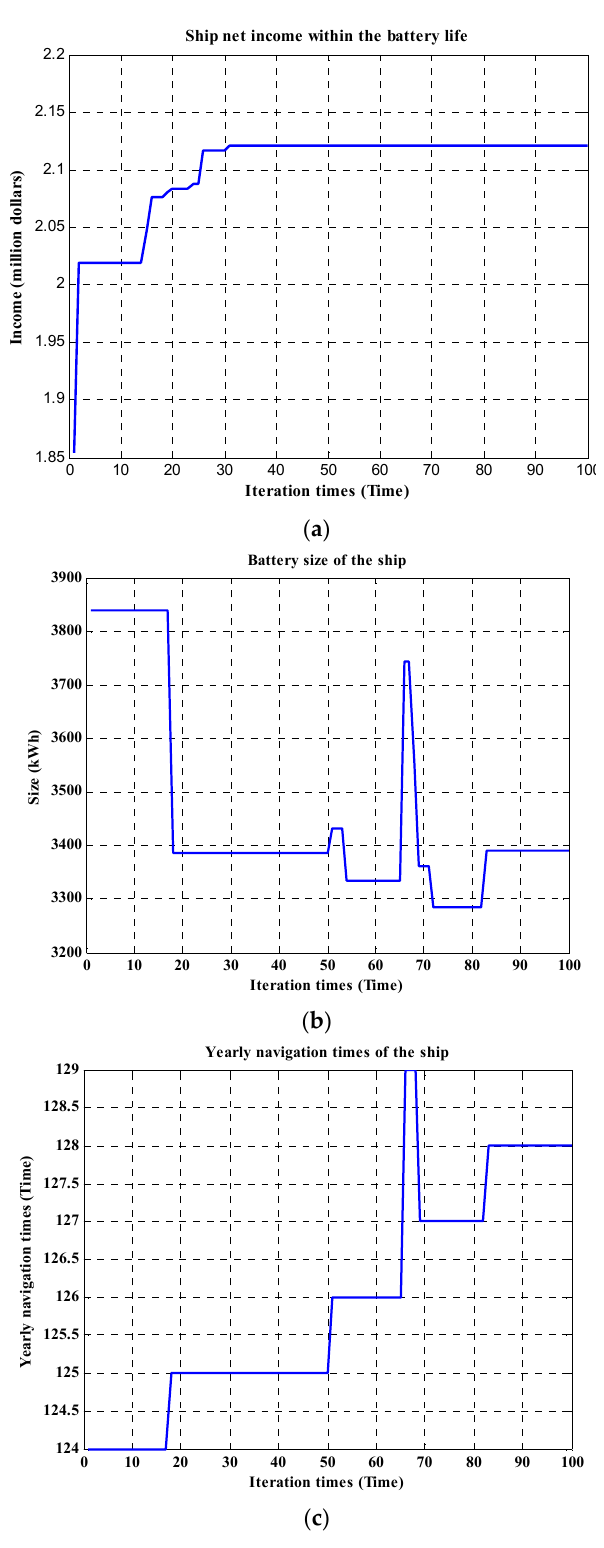
Figure 7. Simulation results of scenario 2 in case 1. ( a ) Variation of ship net income within the battery life over the optimization procedure ( b ) Battery capacity variation over the optimization procedure ( c ) Variation of yearly navigations over the optimization procedure